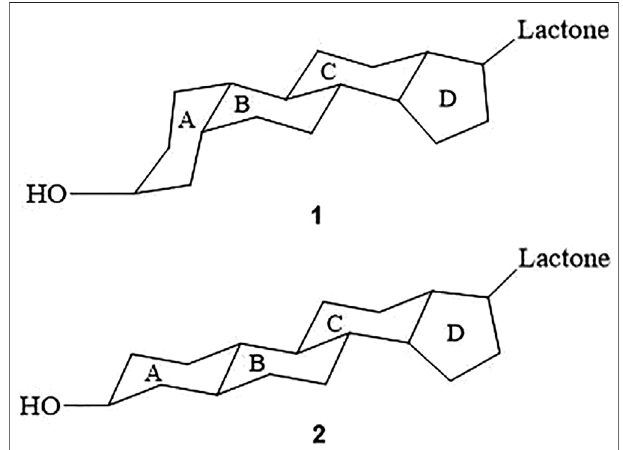
FIGURE 2 | Spatial con fi guration of CTS. Ring A/B and ring C/D of compound 1 are cis-junction, while ring B/C is trans-junction; Ring A/B of compound 2 is transfused which is less